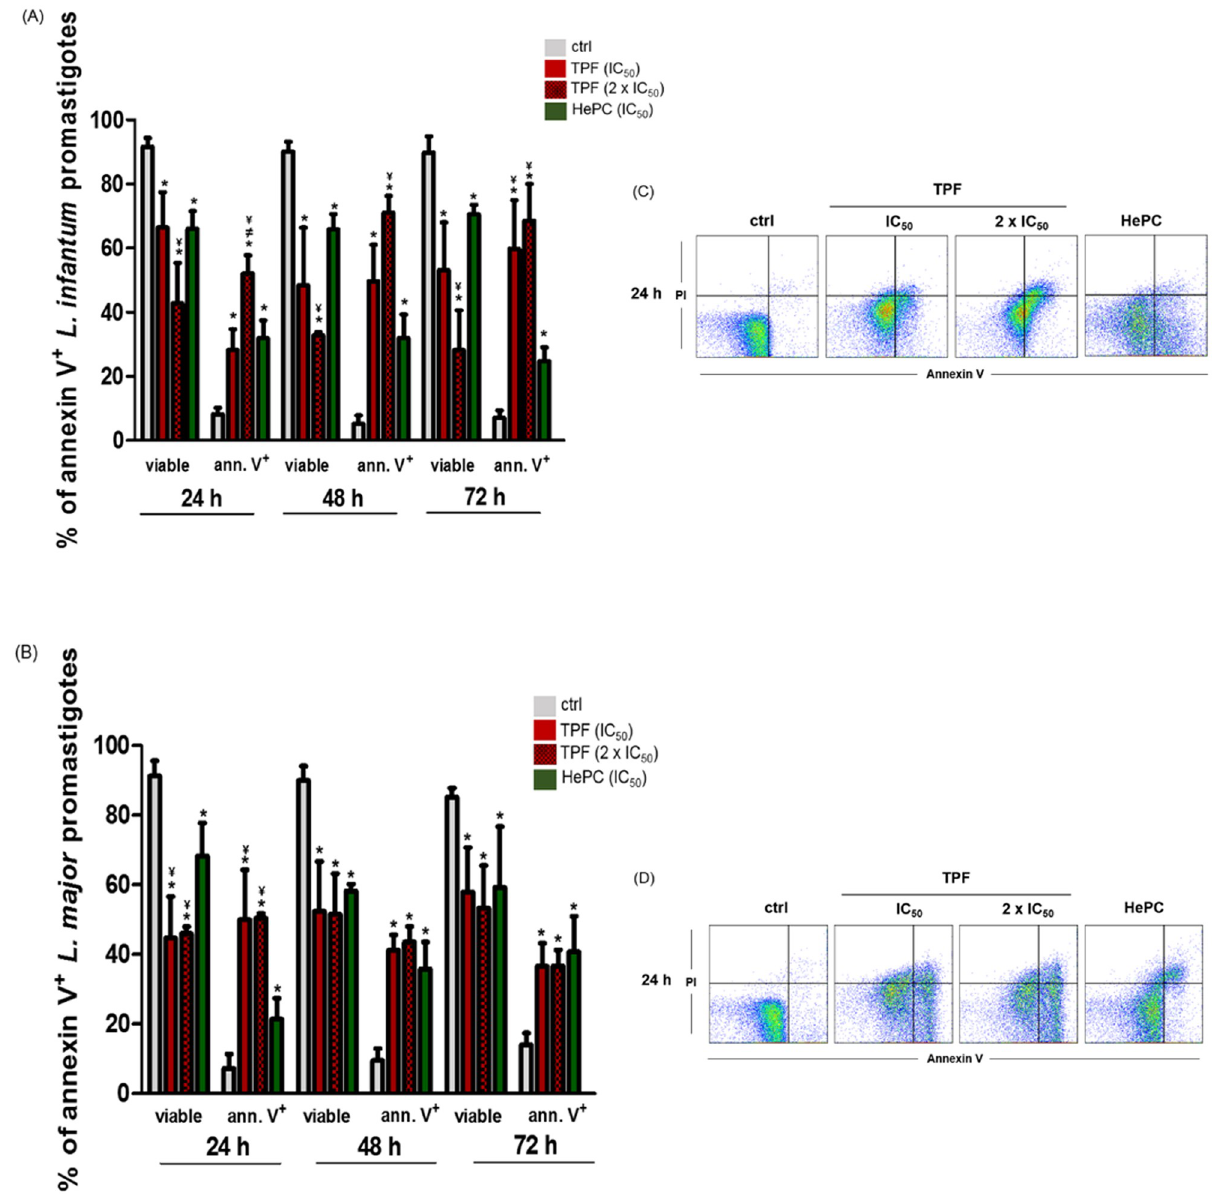
Fig 6. PS externalization in TPF-treated L . infantum and L . major promastigotes. Exponential-phase L . infantum (A, C) and L . major (B, D) promastigotes were either left untreated (negative control) or were treated with IC 50 and 2 x IC 50 concentrations of TPF and HePC (IC 50 , positive control) for 24, 48 and 72 h. At the end of the aforementioned time-points, parasites were double stained with annexin V-FITC and PI and were analyzed by FACS. The results are presented as mean values of % annexin V+ parasites ± SD in bar diagrams (A, B) representative of three independent experiments and as flow cytometric dot plots with respective quadrants (C, D), representative of one experiment. Symbols of � and ¥ indicate statistically significant differences compared to negative and positive control groups, respectively while 6¼ indicates significant differences between TPF groups.